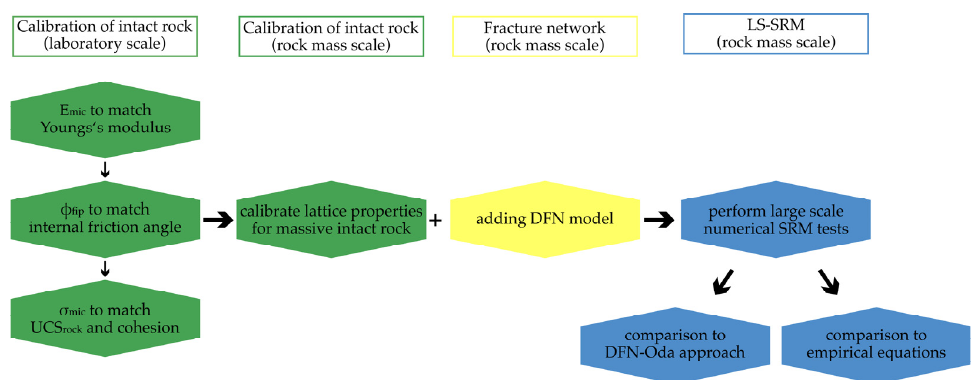
Figure 2. General workflow for determining fractured rock mass properties using the LS-SRM approach and comparing them with the DFN-Oda-Geomechanics approach and empirical equations based on rock mass classification schemes.